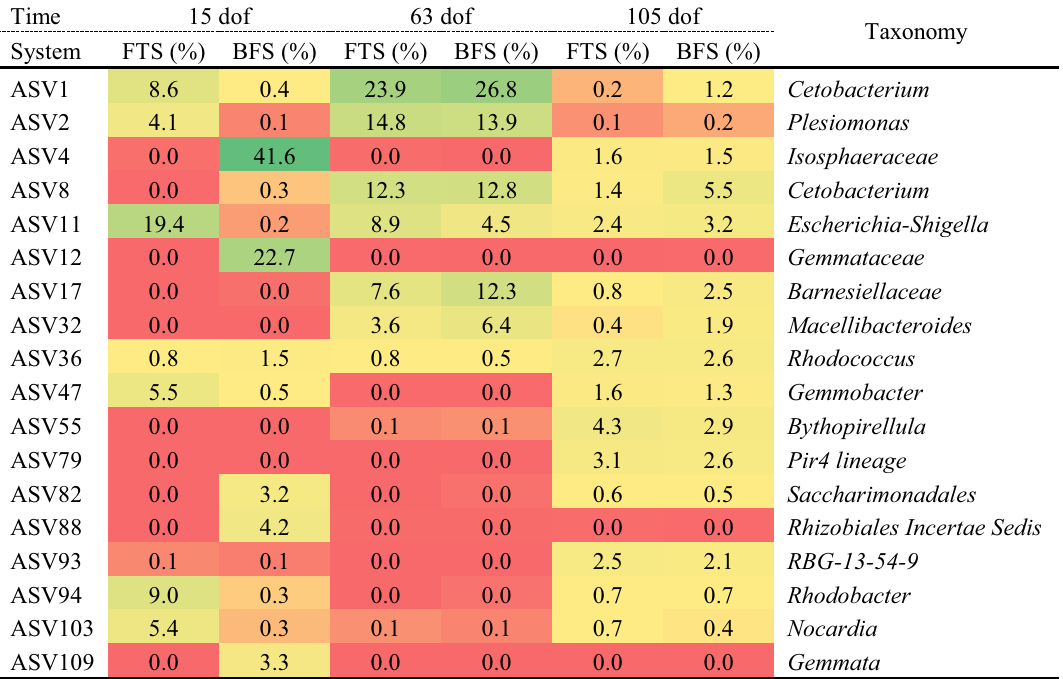
Table 2 Relative abundance and taxonomy of the top 5 ASVs from fish cultured in FTS and RAS at dof 15, 63 and 105. The top 5 ASVs detected in each sampling day and each rearing system were calculated throughout all